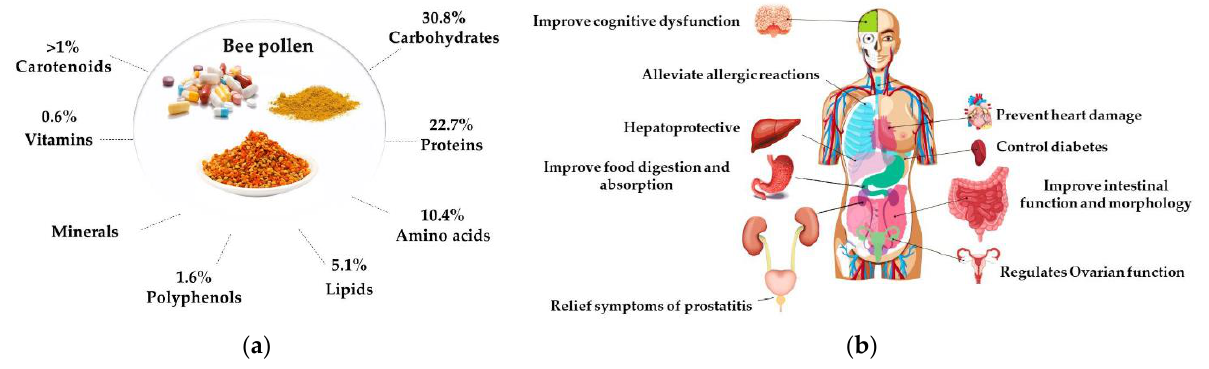
Figure 8. Bee pollen: ( a ) main constituents; ( b ) therapeutic applications (adapted from